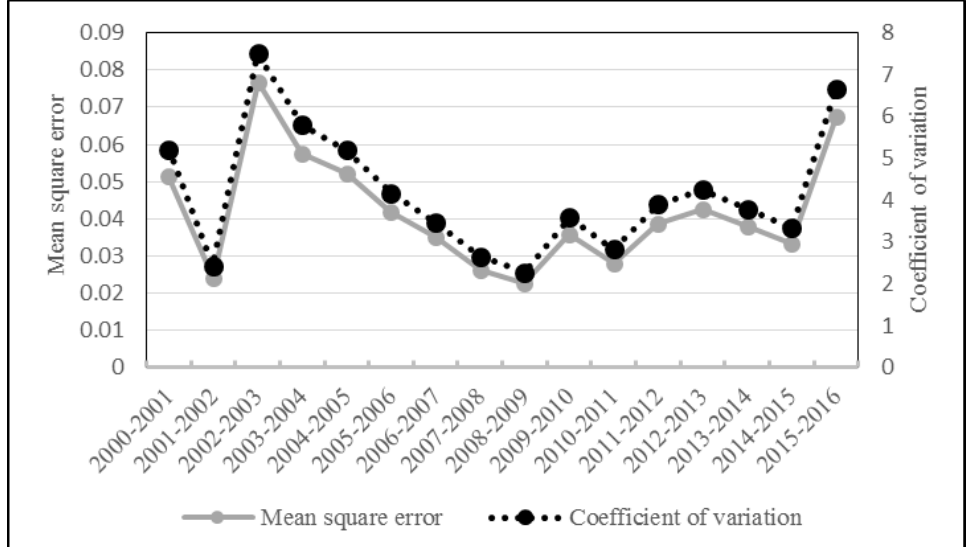
Figure 10. Changes in average variance and the coefficient of variation of STC.